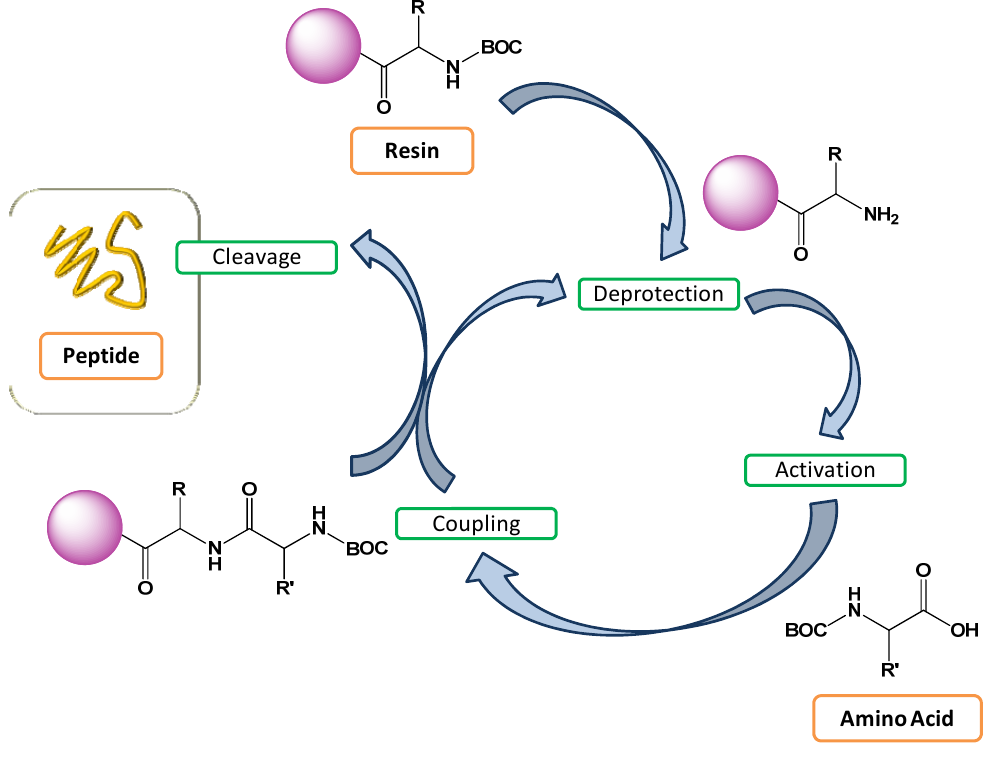
Figure 3. Schematic representation of Merrifield solid-phase peptide synthesis